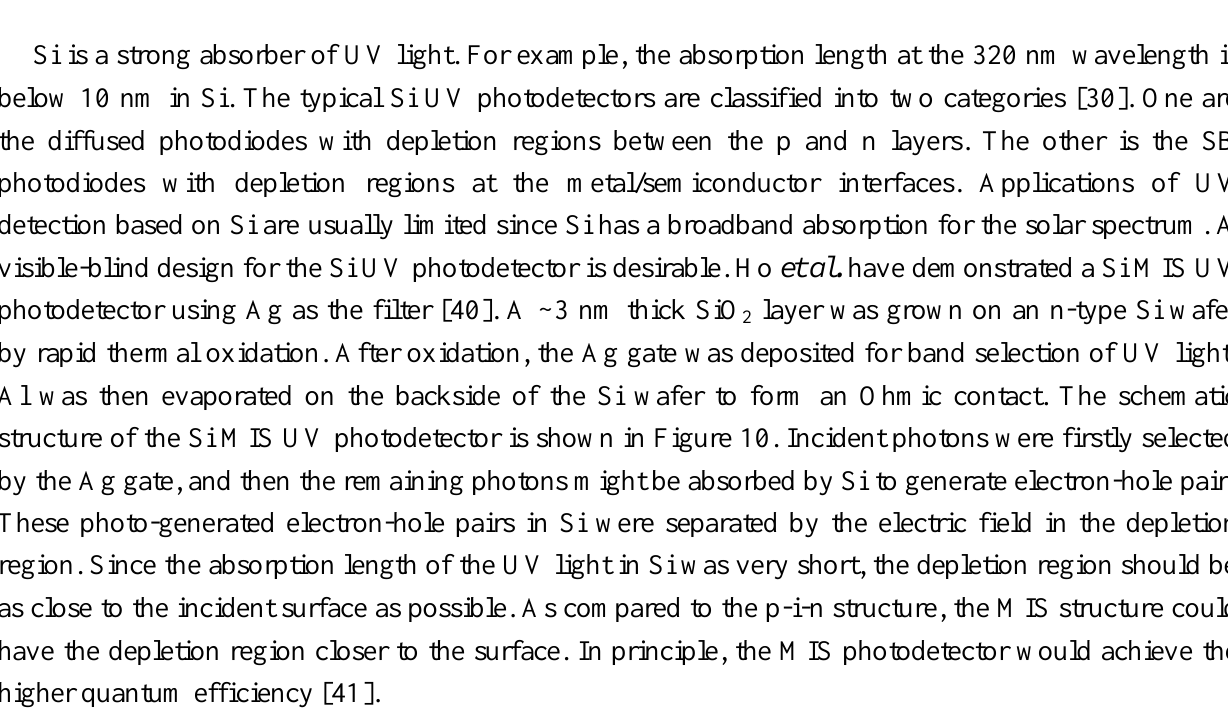
Figure 10. The schematic structure of a metal-filter (such as Ag) Si MIS UV photodetector. Incident photons were firstly selected by the gate, and then the remaining photons might be absorbed by Si to form the